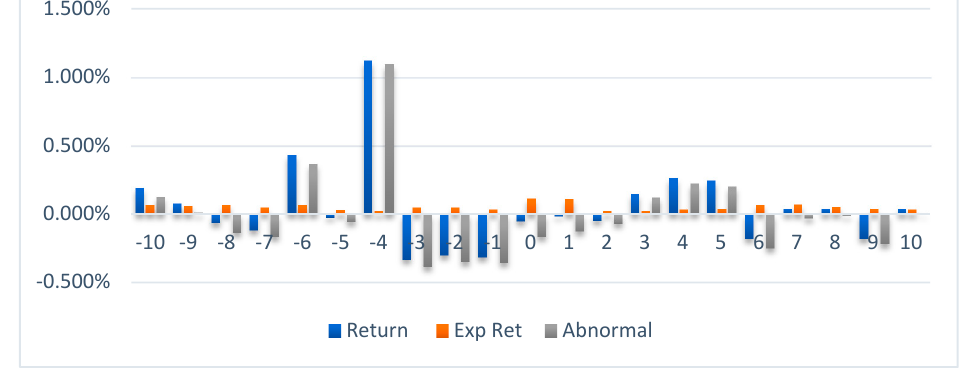
Int. J. Financial Stud. 2018 , 6 , x FOR PEER REVIEW